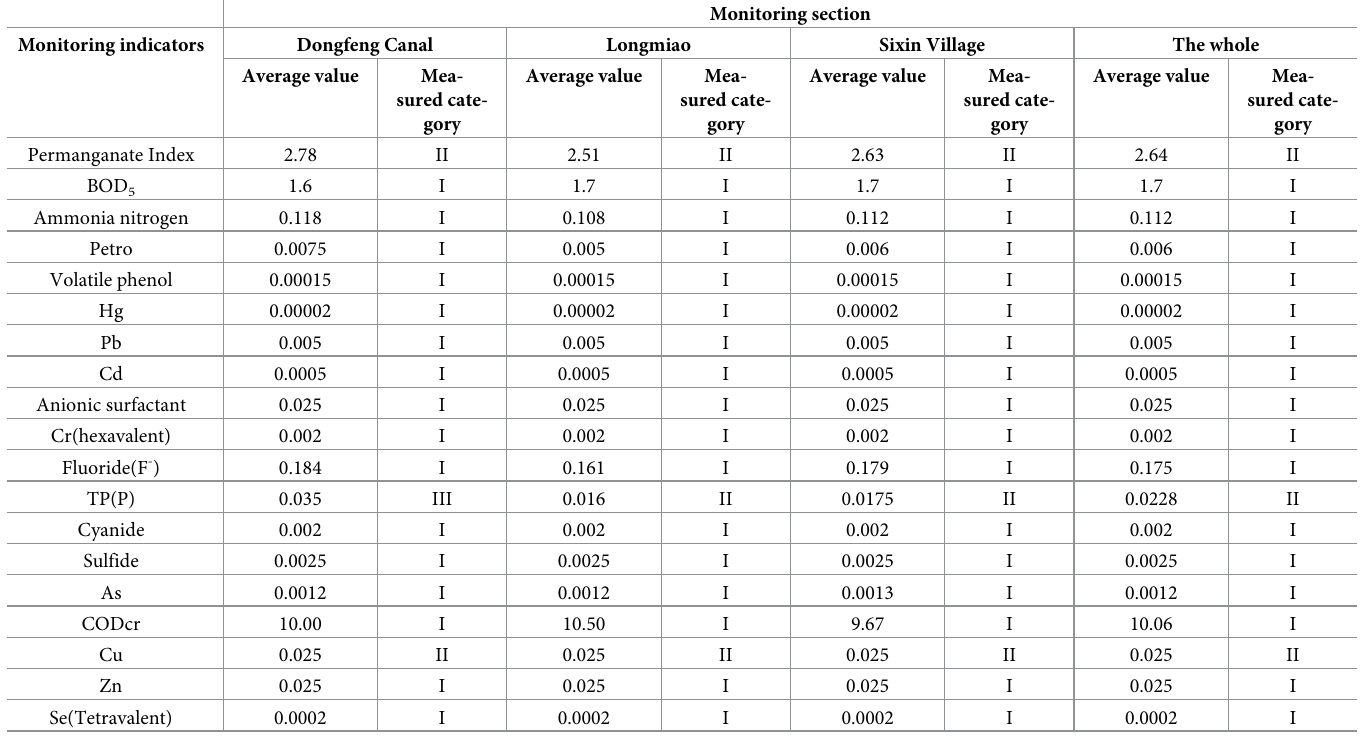
Table 4. Statistical results of various indicators in Heilongtan Reservoir in